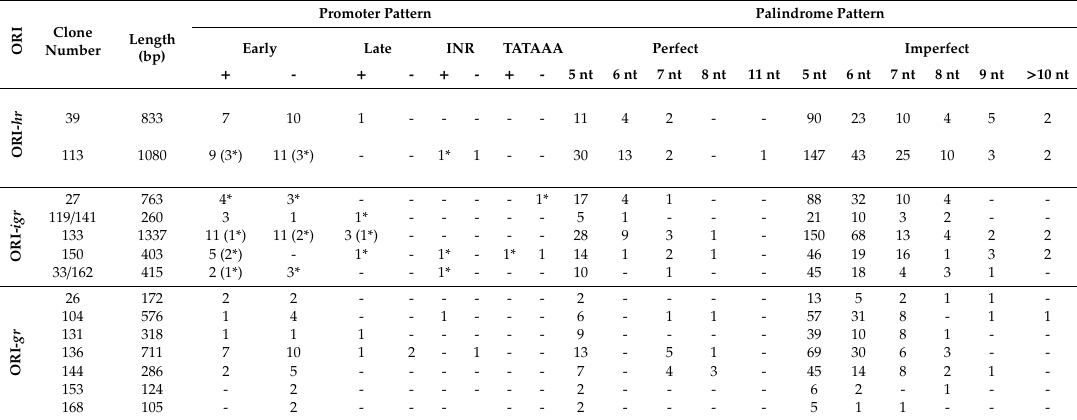
Table 2. Palindromes and promoters contained in ORIs of